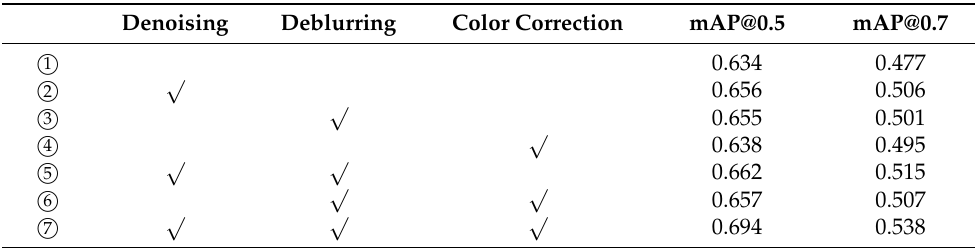
Table 3. Ablation experiment results of the three sub-modules. The “ sponding sub-module has been added to the framework.